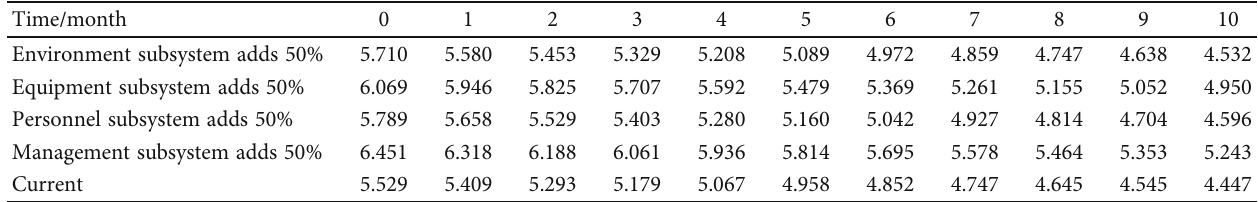
Table 8: Simulation results of adaptability